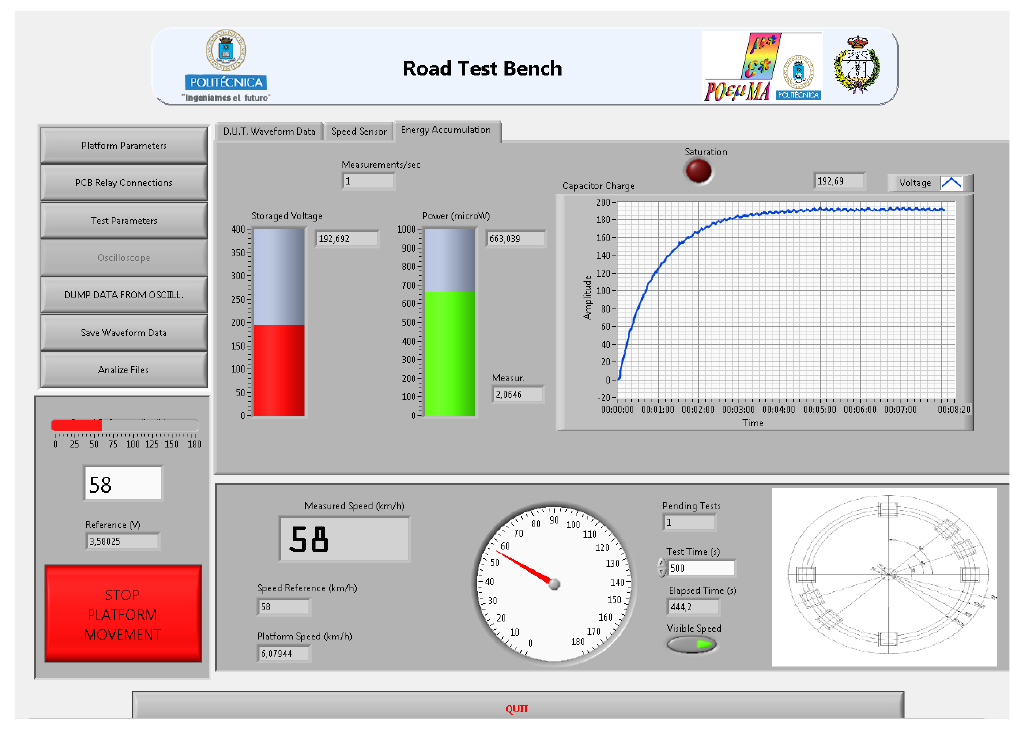
Figure 5. Practical test results.